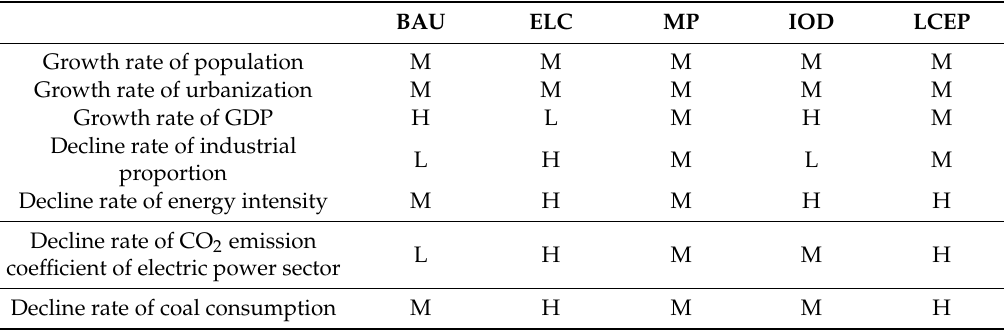
Table 1. Parameter levels used in five